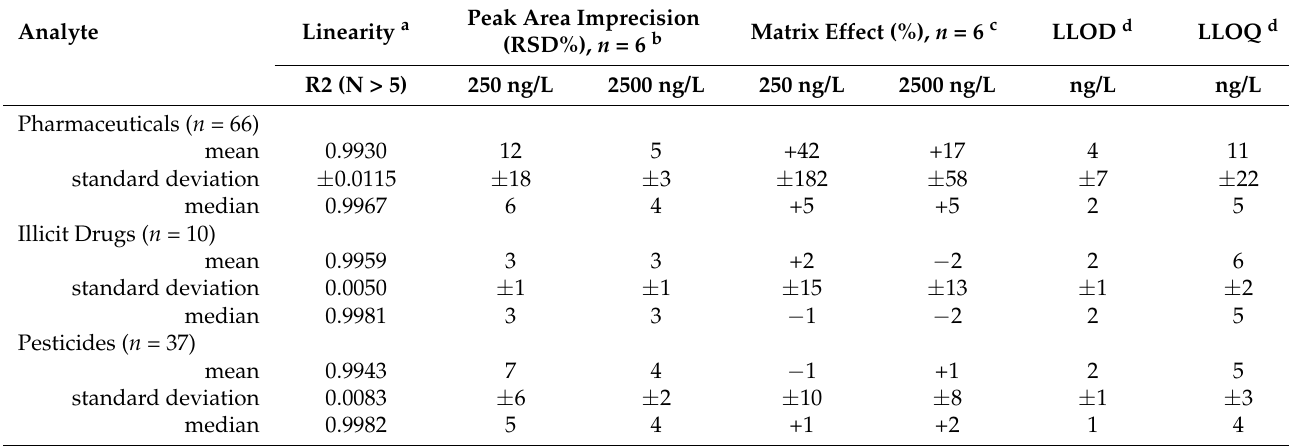
Table 1. Analytical performance data for the direct-injection LC-MS/MS method performed in river water matrix according to ICH guidelines